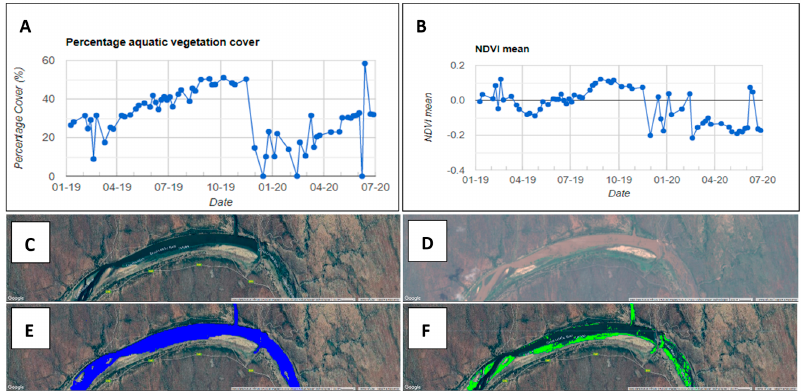
Figure 3. The ability of the introduced workflow’s (Figure 2) stage 1 and 2 to monitor aquatic vegetation cover ( A ), associated mean aquatic vegetation normalized difference water index (NDVI) ( B ) from January 2019 to July 2020 for the area depicted in the high resolution google earth image of Engelharddam, Kruger National Park, South Africa ( C ), a RGB Sentinel-2, level 1C (atmospherically uncorrected) image ( D ) with long-term (blue) surface water ( E ) and Otsu + Canny detected (green) aquatic vegetation ( F ) corresponding to the first Sentinel-2 observation of chart A and B (9 January 2019) for the same area ( F ). The application that provides similar charts for any waterbody of interest can be accessed here (script name: Aquatic vegetation and water